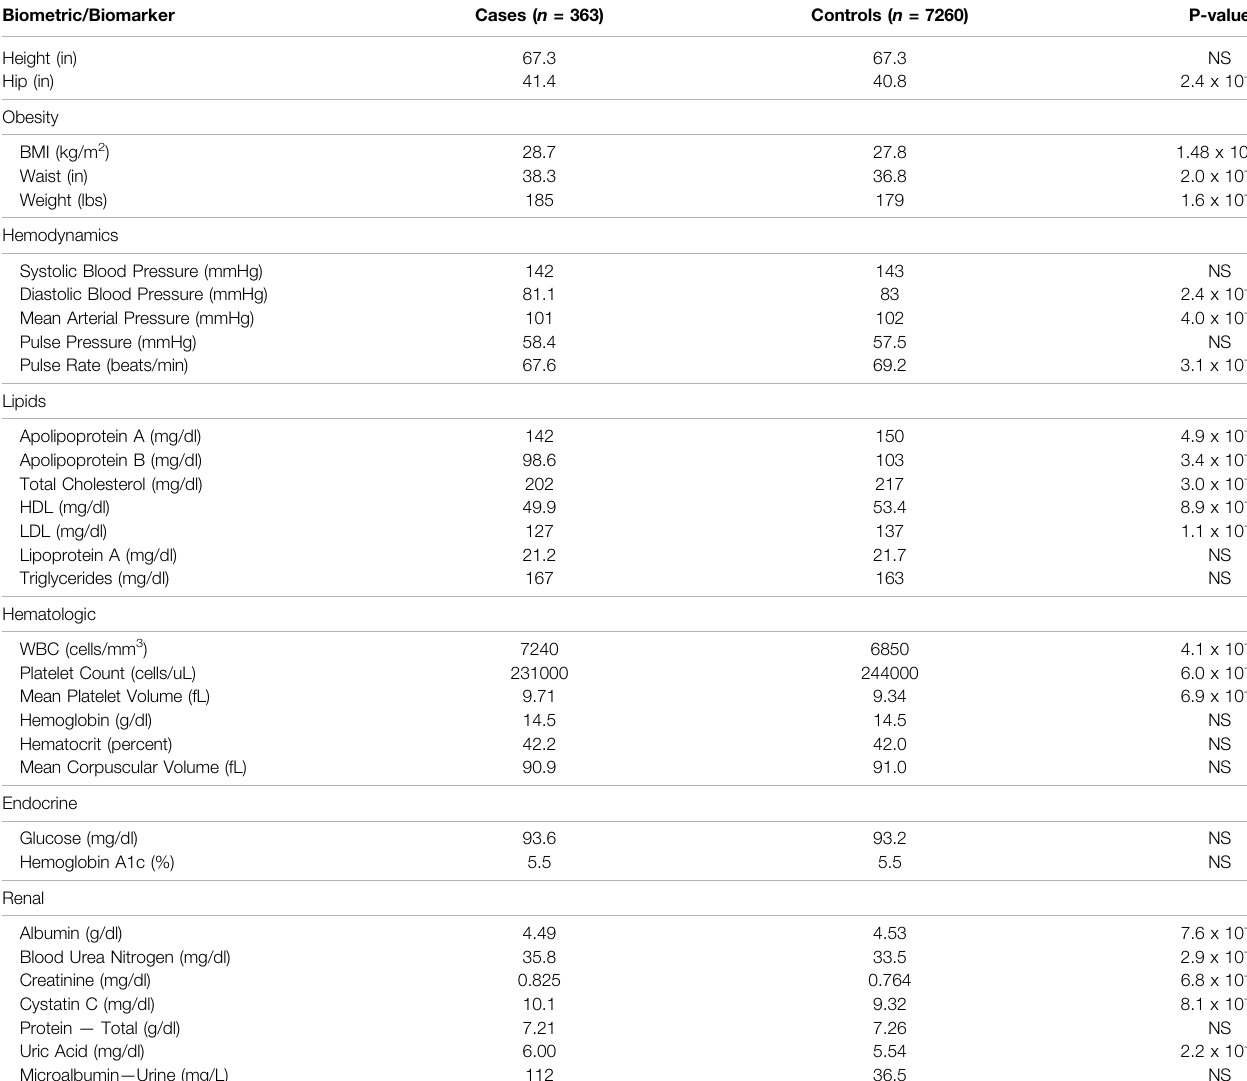
TABLE 2 | Relevant biometrics and biomarkers in cases and controls.